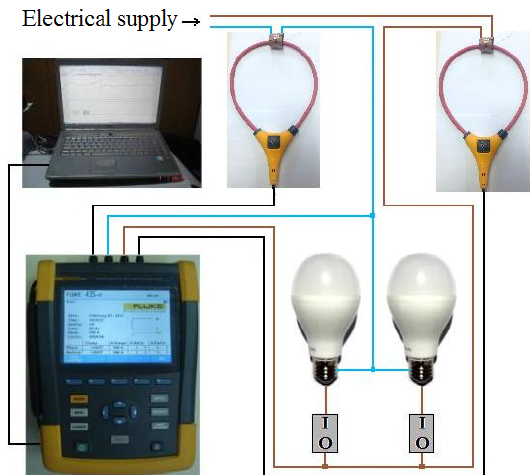
Figure 2: Experimental setup for harmonic